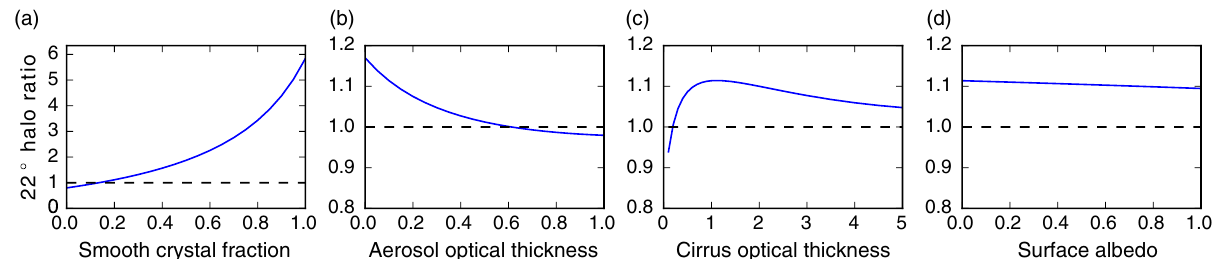
Figure 11. Sensitivity studies of the 22 ◦ halo ratio at 550nm (as defined in Eq. 1) as a function of smooth crystal fraction, aerosol optical thickness (AOT), cirrus optical thickness (COT) and surface albedo (from left to right). The radiative transfer simulations were performed with libRadtran assuming an ice cloud between 10 and 11km using ice crystal optical properties as in Fig. 10 for a solar zenith angle of 60 ◦ . The dashed line indicates HR = 1, which marks the threshold for the visibility of a halo display. The default parameters, i.e., if not varied, are 20% smooth solid columns, AOT = 0 . 2, COT = 1 . 0 and albedo = 0 . 0.